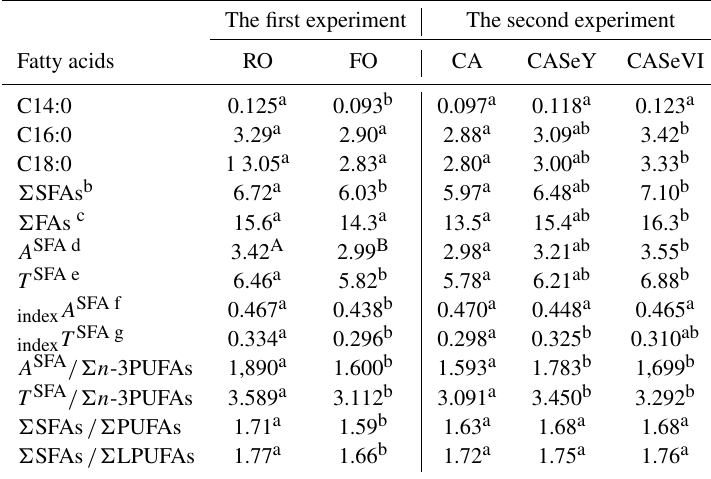
Table 3. The concentrations (mgg − 1 ) of fatty acids, indexes of A SFA ( index A SFA ) and T SFA ( index T SFA ), and the concentration ratios of (cid:54) SFAs to (cid:54) FAs, (cid:54) PUFAs or (cid:54) LPUFAs in the brains of lambs a . The first experiment The second experiment Fatty acids RO FO CA CASeY CASeVI C14:0 0.125 a 0.093 b 0.097 a